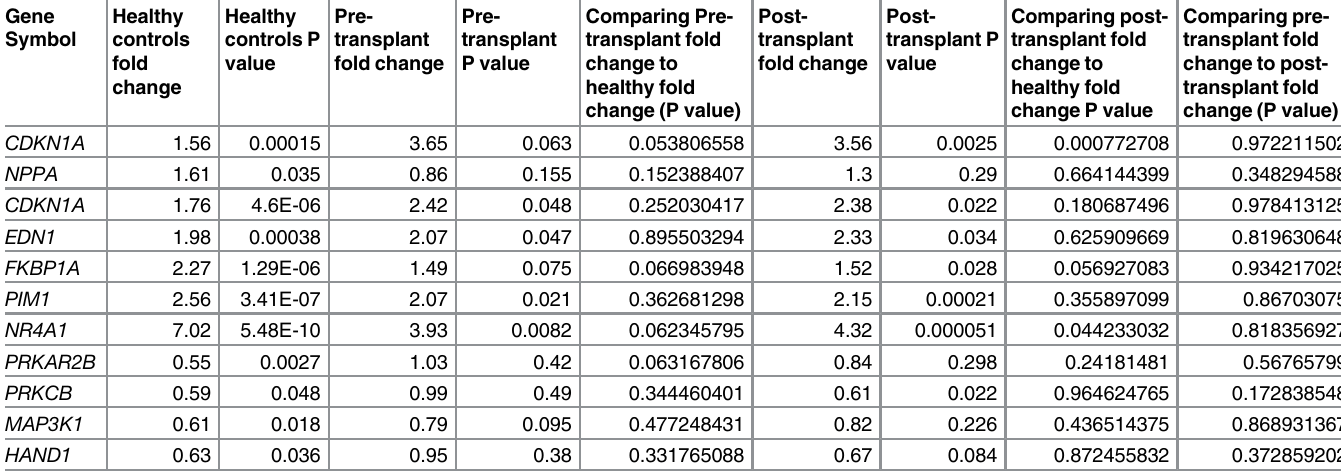
Table 3. NFAT Gene